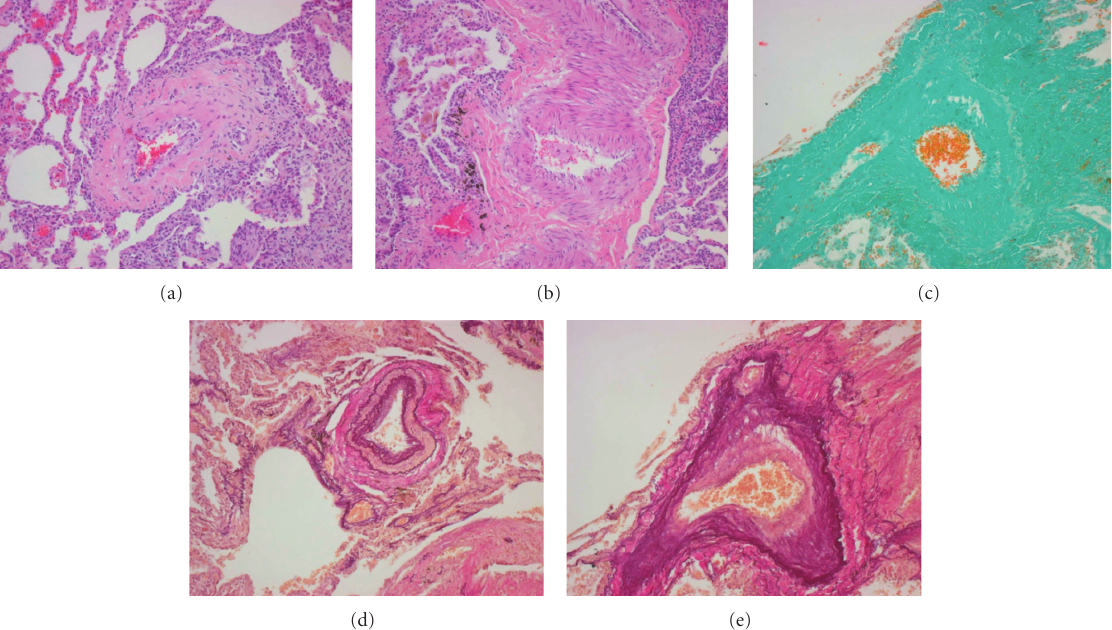
Figure 4: (a–e) Pulmonary Langerhans cell granulomatosis, pulmonary vessels, histological findings in 2005. (a, b) HE: H¨amatoxylin-Eosin stain, (c) MG: Masson-Goldner-stain, and (d, e) EVG: Elastica van Gieson